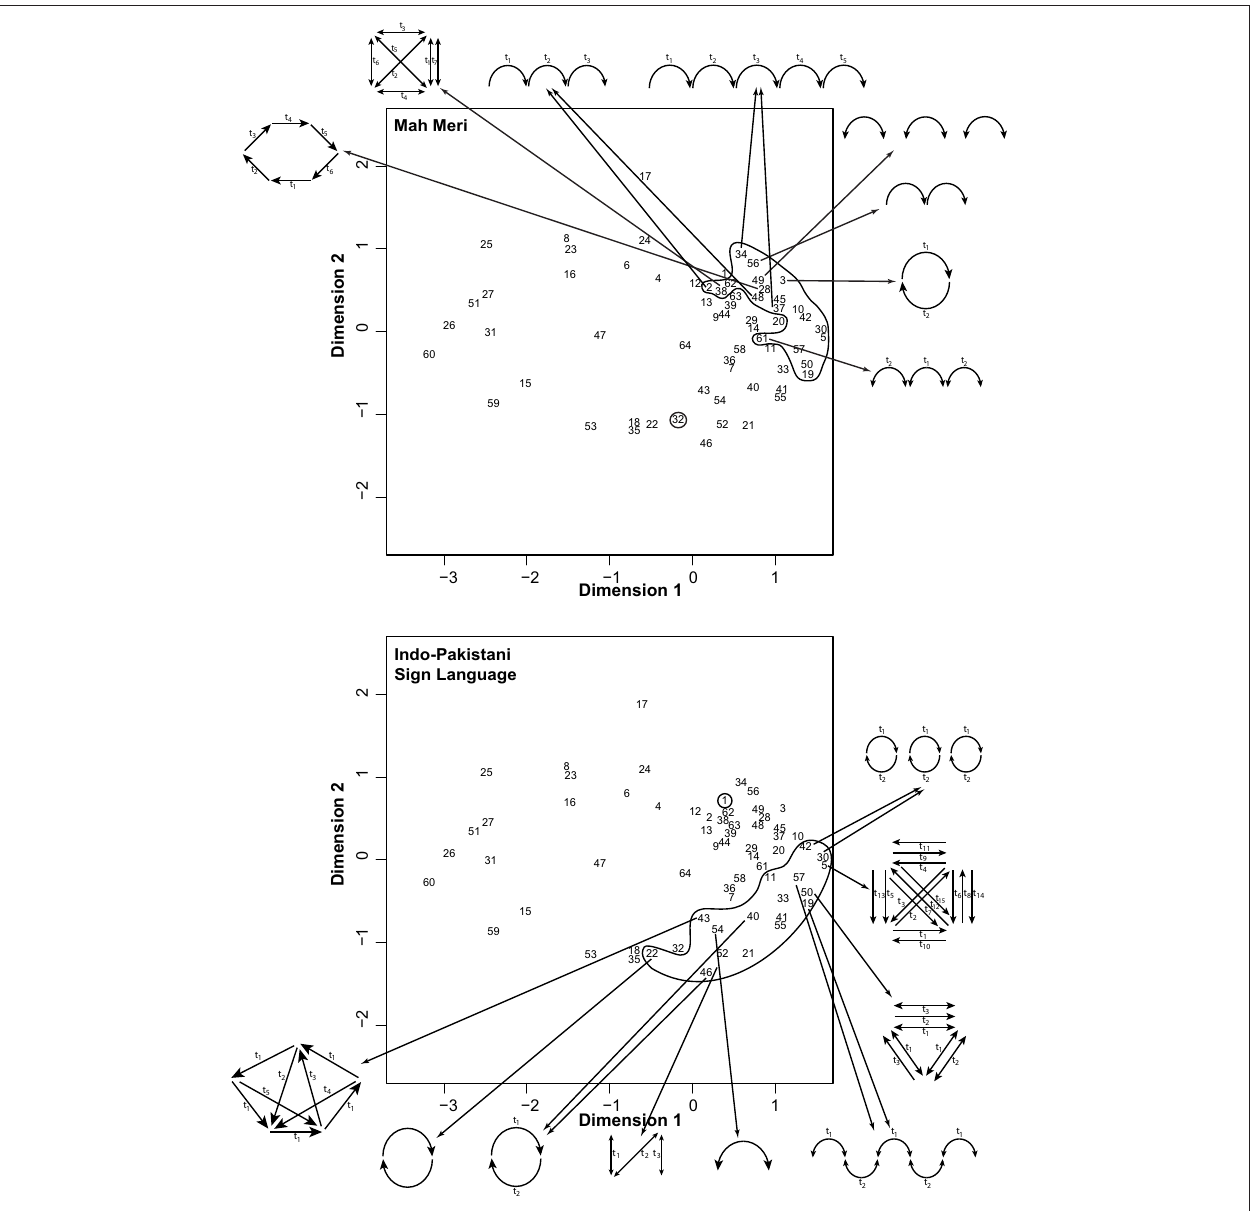
cluster at the more inclusive end of extensional space: in effect, less than a third of languages are highly selective in their applica- tion of